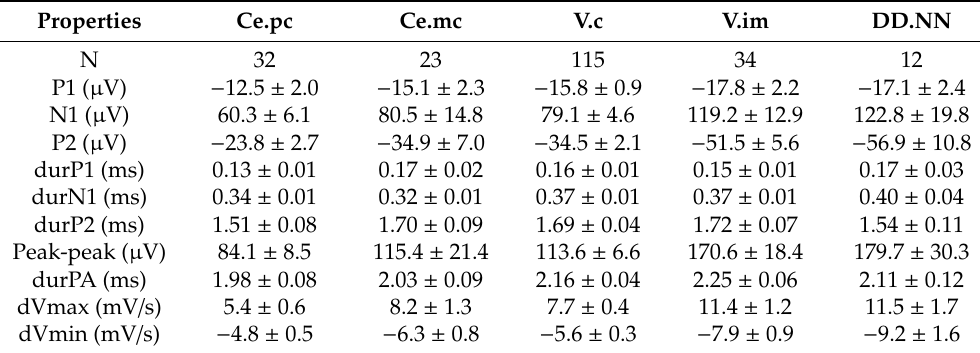
Table A3. Properties of mAP for P1N1P2. Values as x ± SEM , except of N , which indicates the number of mAP picked up from every nucleus.